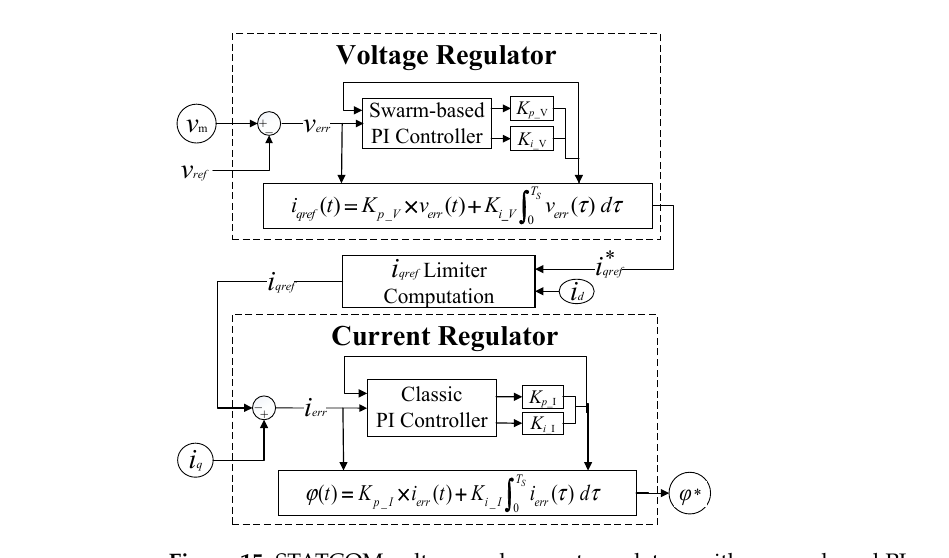
Figure 15. STATCOM voltage and current regulators with swarm-based PI controller.